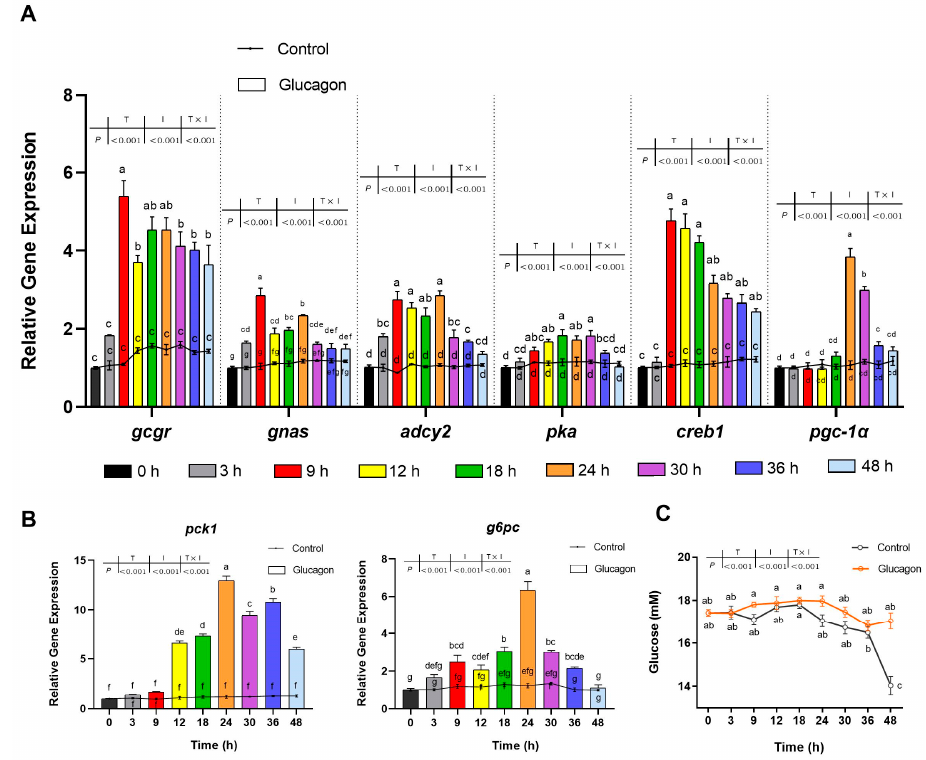
Figure 2. Time-dependent effects of glucagon treatment on gene expression in hepatocytes and glucose concentration in the medium. ( A ), qPCR analysis of the mRNA levels of glucagon pathway- related genes ( gcgr ; gnas ; adcy2 ; pka ; creb1 ; pgc-1 α ) in hepatocytes at different times in response to glucagon treatment (1 µ M) or DMSO. ( B ), qPCR analysis of the mRNA levels of gluconeogenic genes ( pck1 and g6pc ) in hepatocytes at different times in response to glucagon treatment (1 µ M) or DMSO. ( C ), Glucose concentration in the medium at different times in response to glucagon treatment (1 µ M) or DMSO. All data are expressed as mean ± SE, n = 3, two-way ANOVA with Tukey post-hoc test. Values with different letters mean statistical differences ( p < 0.05). T: time points; I: reagents for incubation; T × I: interaction between time and